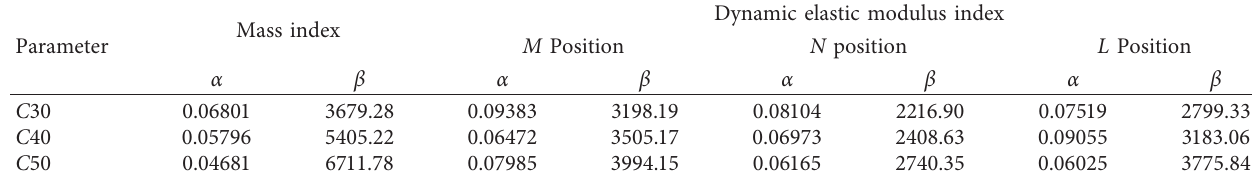
Table 4: Estimated parameters of B–S life